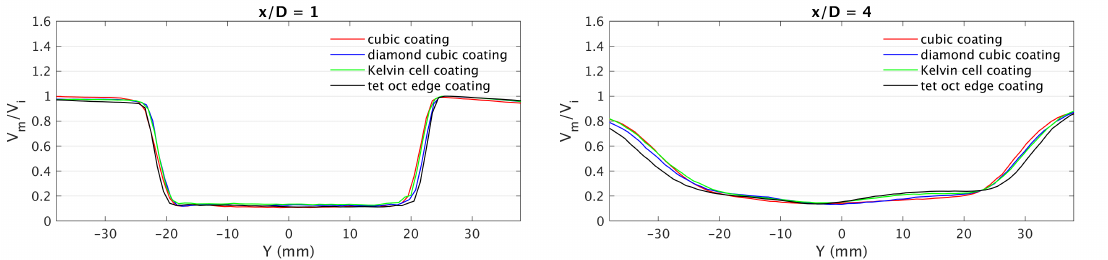
Figure 22. Velocity profiles for cylinder 16 and 18–20.